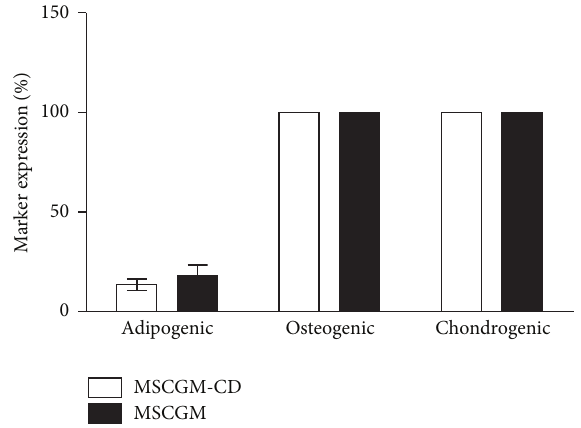
Figure 5: hMSC differentiation assays. MSCGM (black) as well as MSCGM-CD (white)-cultured cells revealed to be 100% positive for expression of osteogenic and chondrogenic lineage markers. Com- mitment along adipogenic lineage occurred in 13.51% of MSCGM- CD and in 18.37% of MSCGM propagated cells. Cells were counted in 10 high power fields that contained at least 100 cells, and the amount of nuclei (representing total amount of cells) was compared with the amount of cells positive for the differentiation marker. Data presented as mean ± SEM ( 𝑛 = 5 ). Unpaired two-tailed 𝑡 -test demonstrated no significant differences between both